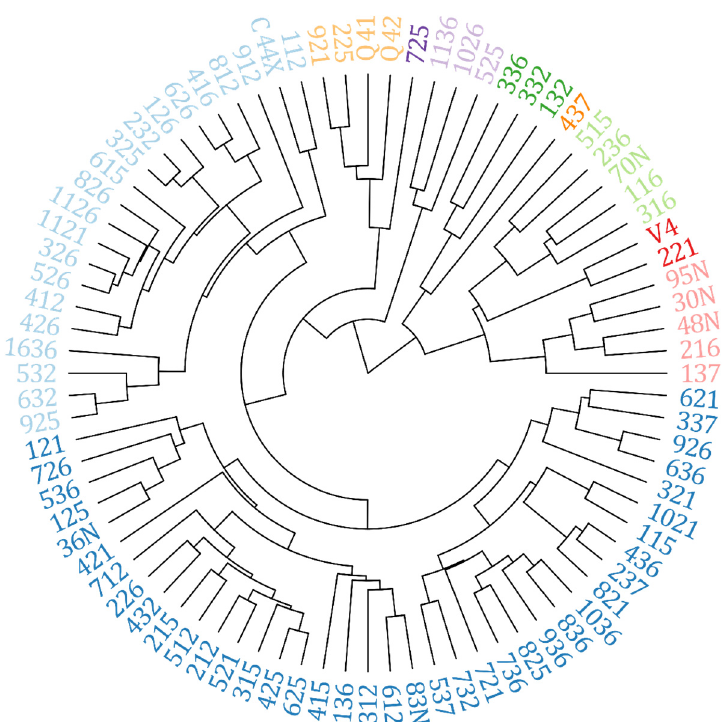
Figure 2. Dendrogram of genetic dissimilarity among 74 intraspecific hybrids and eight parents of P. notatum Flügge, obtained by the UPGMA method, based on the average genetic Euclidean distance matrix considering the yield and morphological characteristics evaluated. Cophenetic correlation index = 0.76. Group I (blue); Group II (light blue); Group III (orange); Group IV (purple); Group V (light purple); Group VI (green); Group VII (orange); Group VIII (light green); Group IX (red) and Group X (light